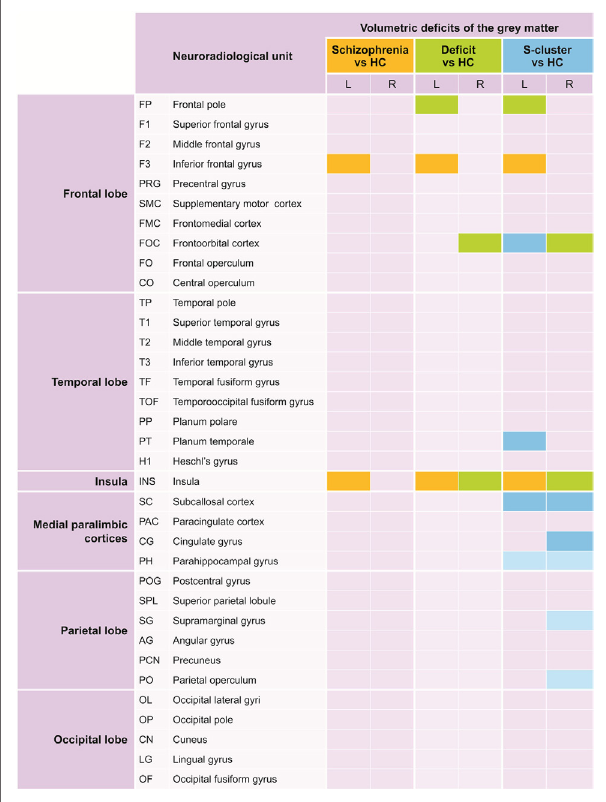
FigUre 2 | A graphical abstract of the volumetric impairments. The figure shows which cortical structures were affected in the different comparisons. The neuroradiological units are presented according to the work of Rademacher and colleagues (25). Alterations detected even on the level of the whole mixed group of patients (related to the healthy controls) are marked in yellow, green color marks alterations detected on the level of the deficit subgroup, and the anomalies detectable exclusively in the cluster S are marked in